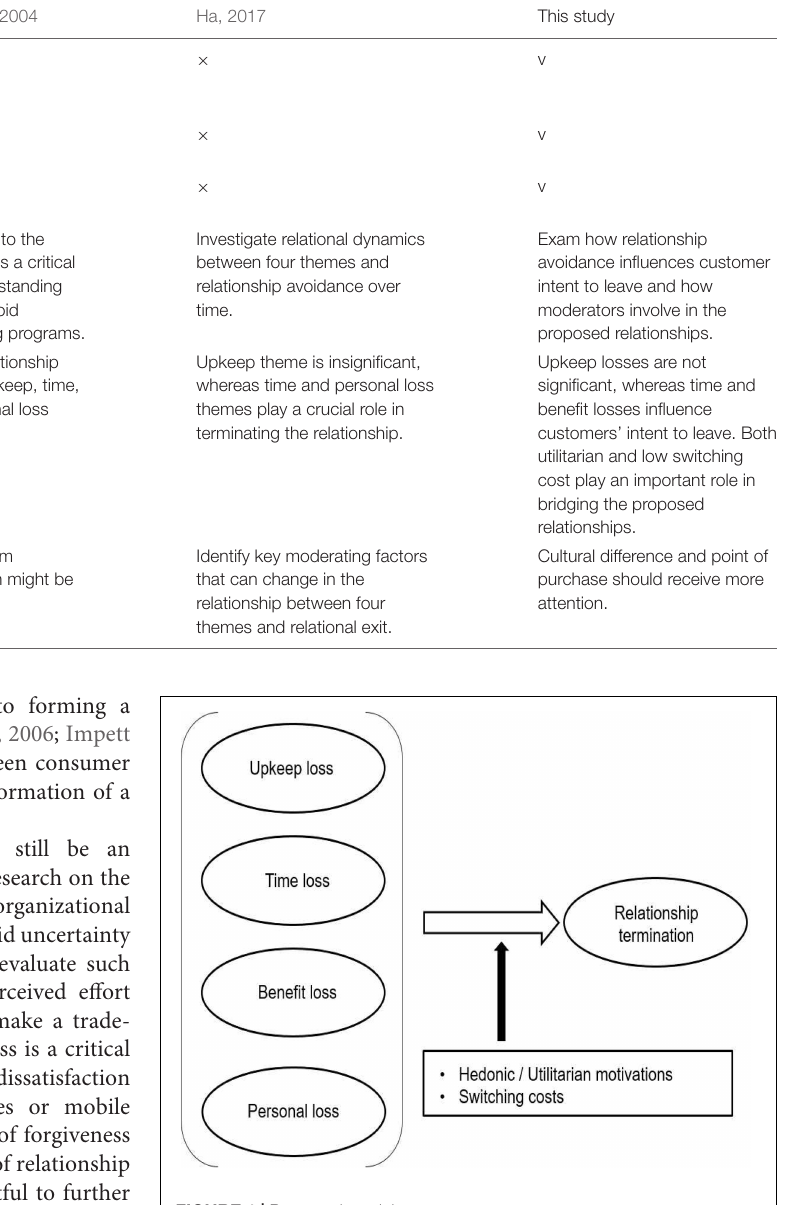
FIGURE 1 | Proposed